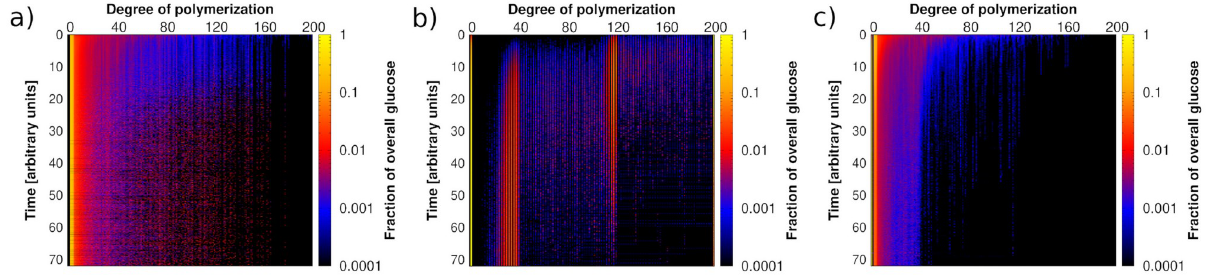
Fig 6. Heatmaps depicting the dynamics over time of the distribution of cellulose polymer degrees of polymerization (DP) for a default microfibril. Time is shown on the ordinate, DP is shown on the abscissa, and color indicates the total amount of glucose that makes up polymers of length DP divided by the total amount of glucose in the system. Present enzymes are xylanase (XYL), together with: EG in (a), CBH in (b), and EG, CBH and BGL all together in (c). In (a), cellotriose accumulates, since in the model EG alone cannot release cellobiose or glucose. In (b) cellobiose progressively accumulates. Finally, in (c), cellobiose can be digested by BGL, and in turn glucose accumulates. Each heatmap represents an average over 100 simulation